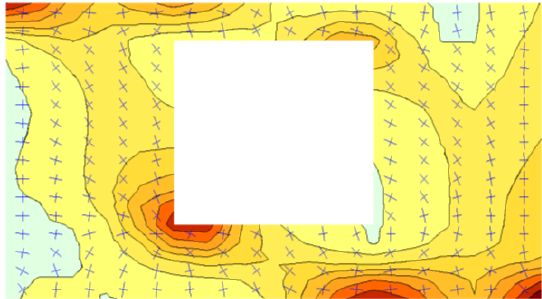
Fig. 5. Map of tensile stresses in the ordinary wall with a window. Maximum tensile stress is 13 kN/m 2